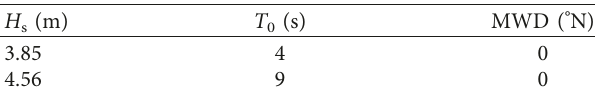
Figure 6: Return level estimation with Weibull distribution (Equation (1)) and confidence